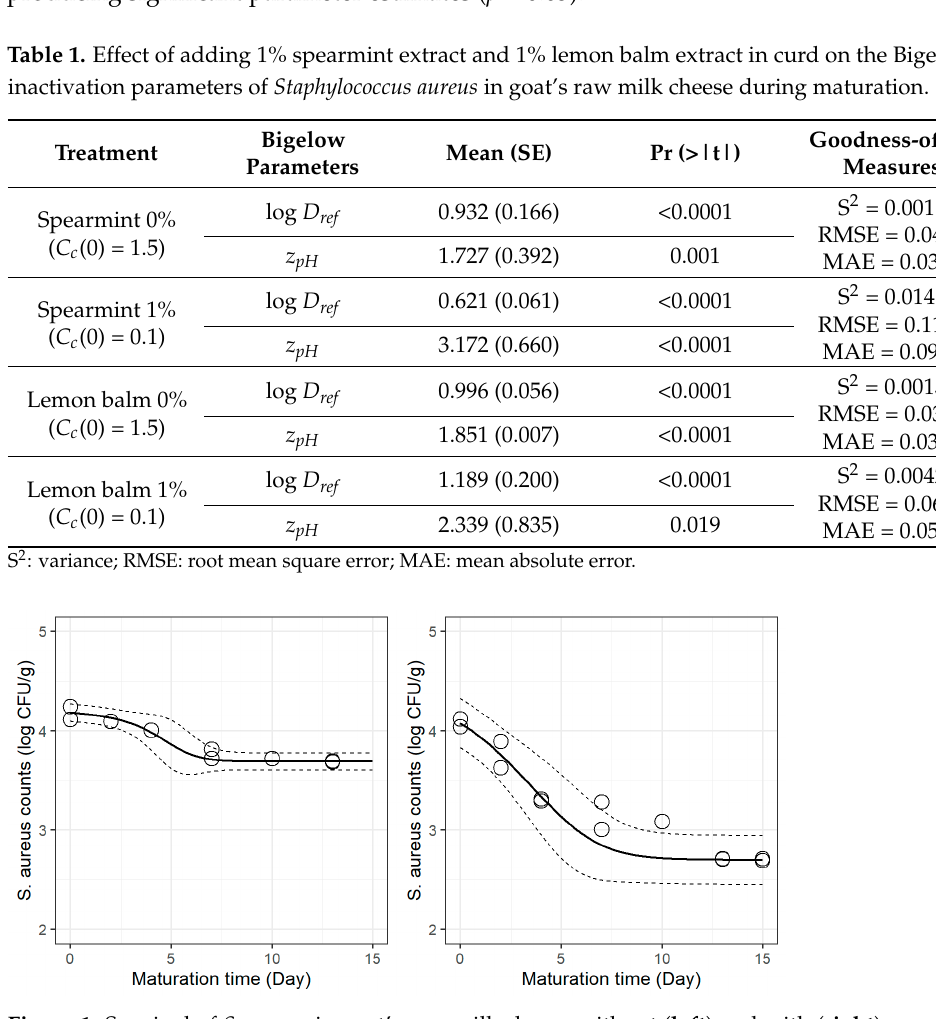
Figure 1. Survival of S. aureus in goat’s raw milk cheese without ( left ) and with ( right ) spearmint extract, as depicted by dynamic models with 95% confidence intervals (dotted lines)